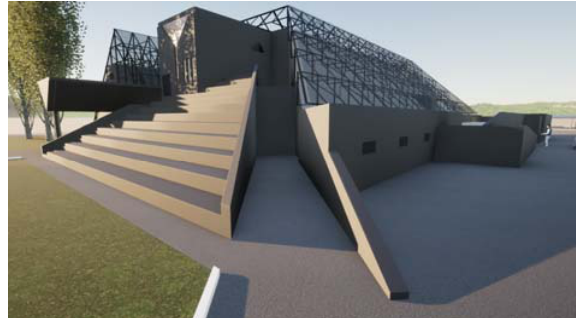
Figure 12 . Simulation of the morphological enhancement inherent in the architectural and urban recovery and regeneration